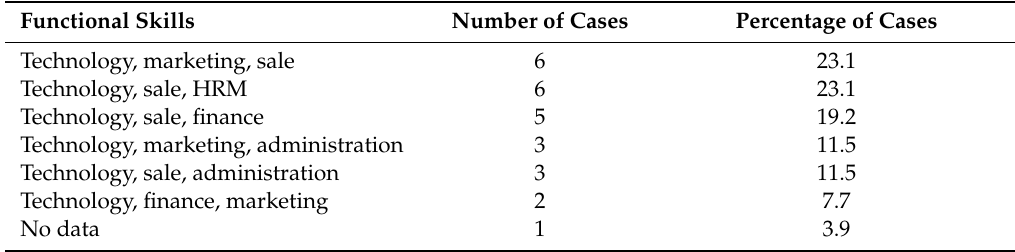
Table 10. Preferred composition of a three-person founder team expressed by the VC managers in the